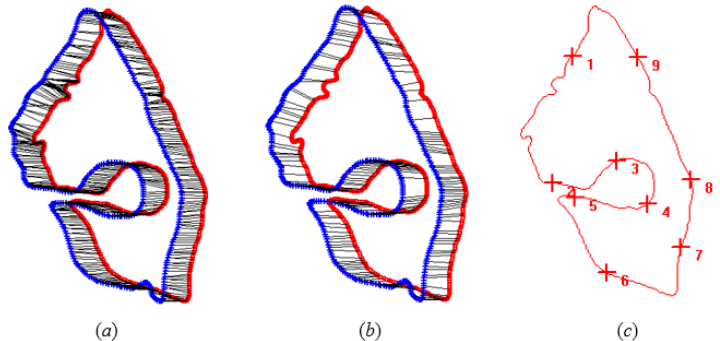
Figure 4. Shape context matching and control point (CP) selection: ( a ) the matching point from shape A to shape B; ( b ) correspondences between the best match pairs, wherein the costs are minimal for the two shapes; ( c ) CPs selected and uniformly distributed on the best match pairs.